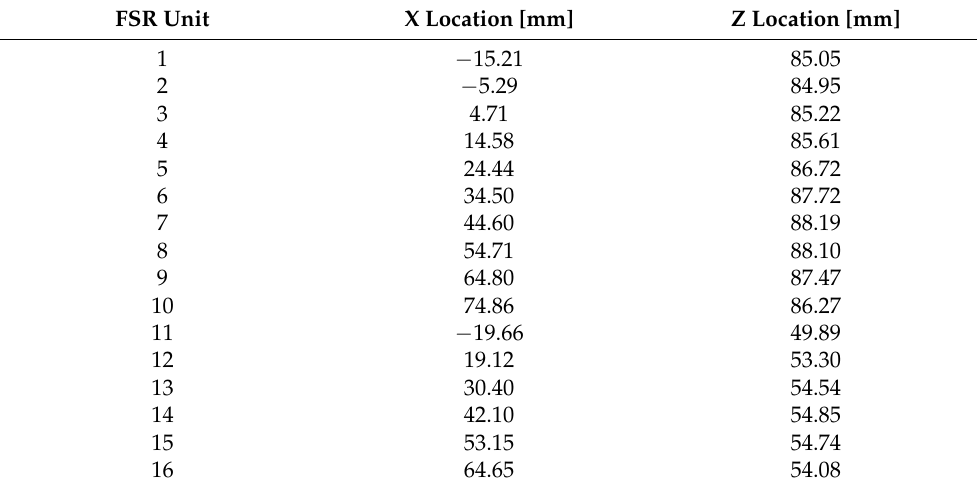
Figure 5. Sagittal view of the handle with the locations of the FSR units marked as crosses. Those under the blue dashed square are used to compute CoMXUp and MPUp ; CoMXDown and MPDown are calculated with the ones under the red dashed square. CoMX and CoMZ use the whole set in x -axis and z -axis directions, respectively. Table 1. FSR locations on the handle, according to the local reference of Figure